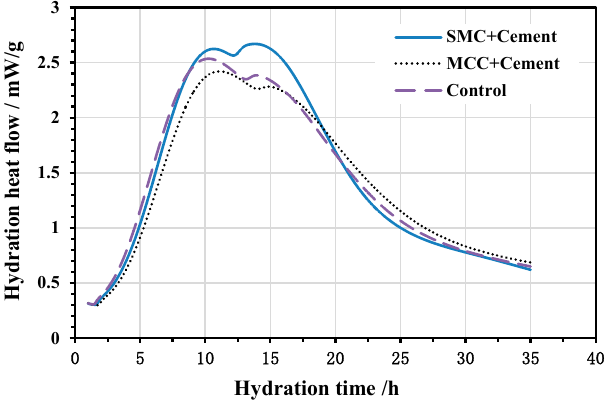
Figure 3. Hydration heat evolution rate curves of cement pastes.